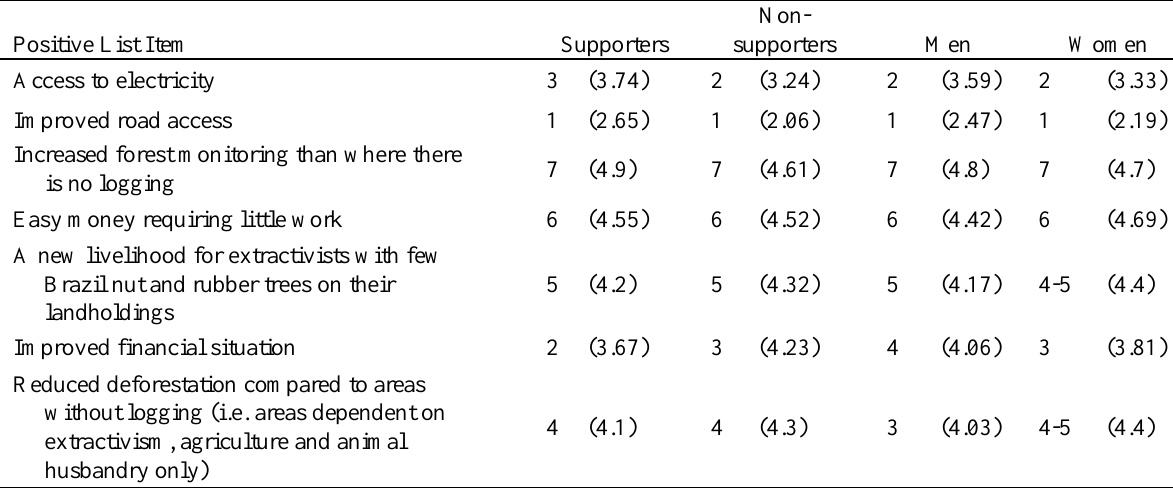
Table A3.1. Results from rank order activity using fixed lists of positive aspects of logging in sustainable use protected areas (1=most important).